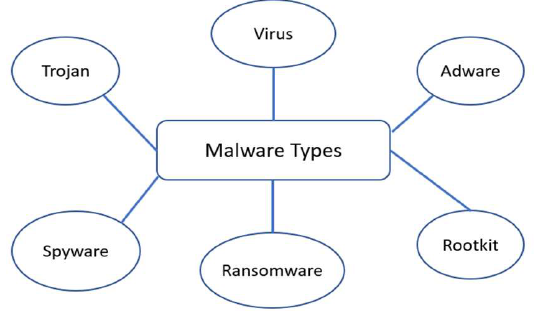
Figure 2. Malware Types.